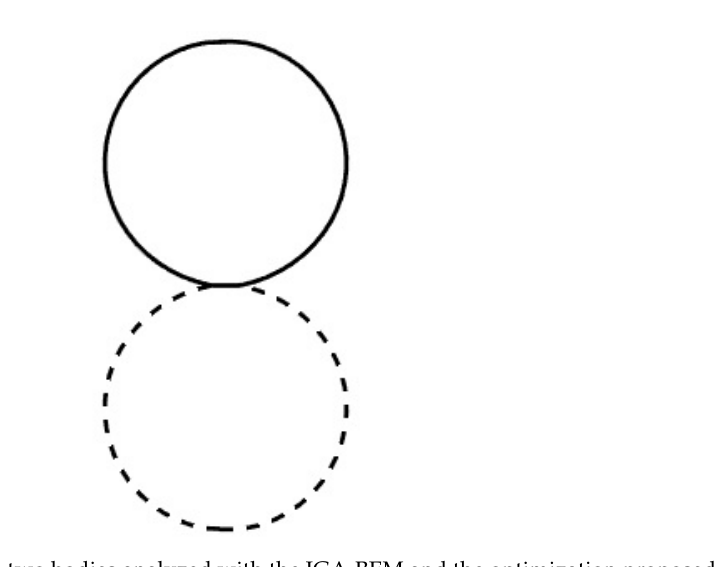
Figure 17. Contact between two bodies analyzed with the IGA-BEM and the optimization proposed.